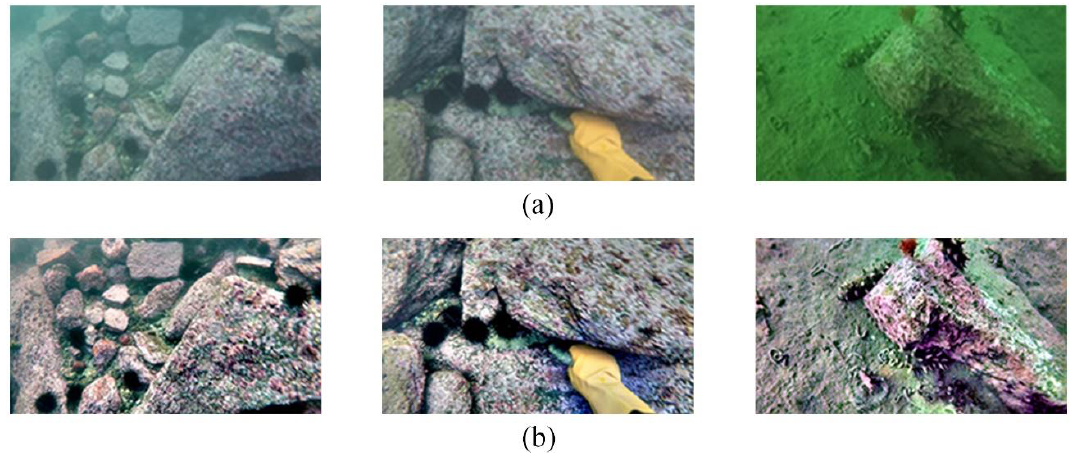
Figure 6. Comparison of ( a ) original images and ( b ) BDYO algorithm output images.